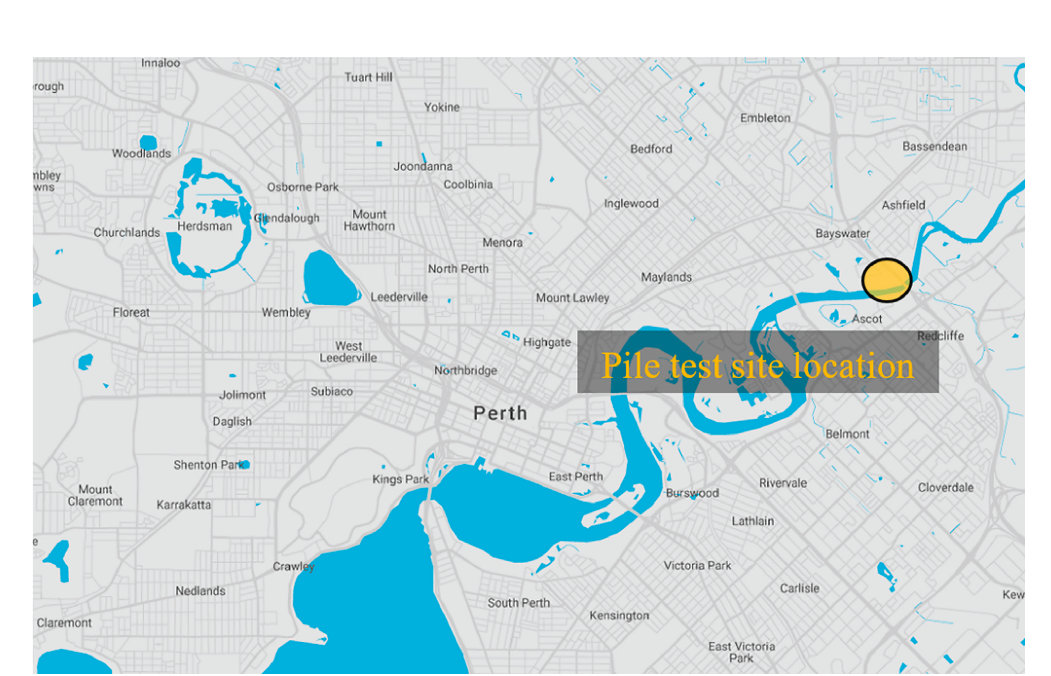
Figure 1: Pile test site location.